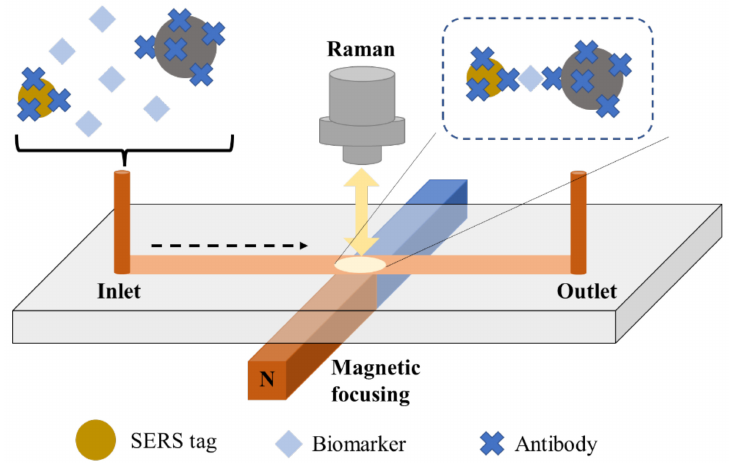
Figure 5. Schematic representation of microfluidic system combined with SERS for biomarker detection based on antigen–antibody interactions (based on [87]).